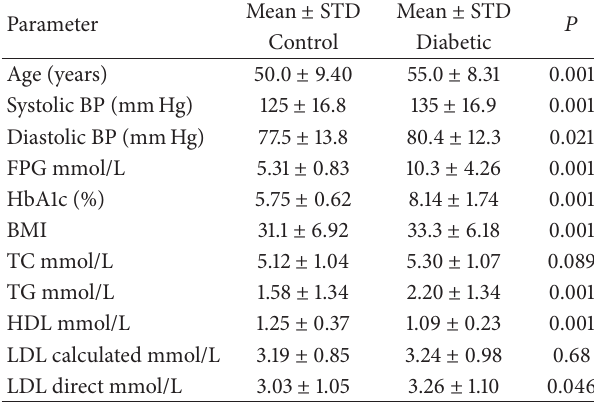
Table 1: Comparison between diabetic and control subjects with regard to different